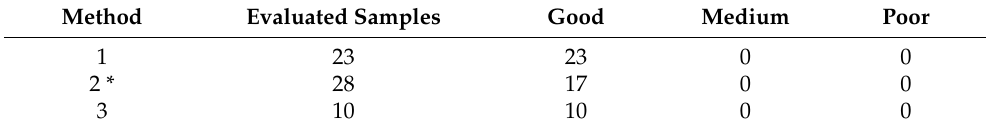
Table 1. Results of quality checks of the BH2012 layer (included in the downloaded zip file).